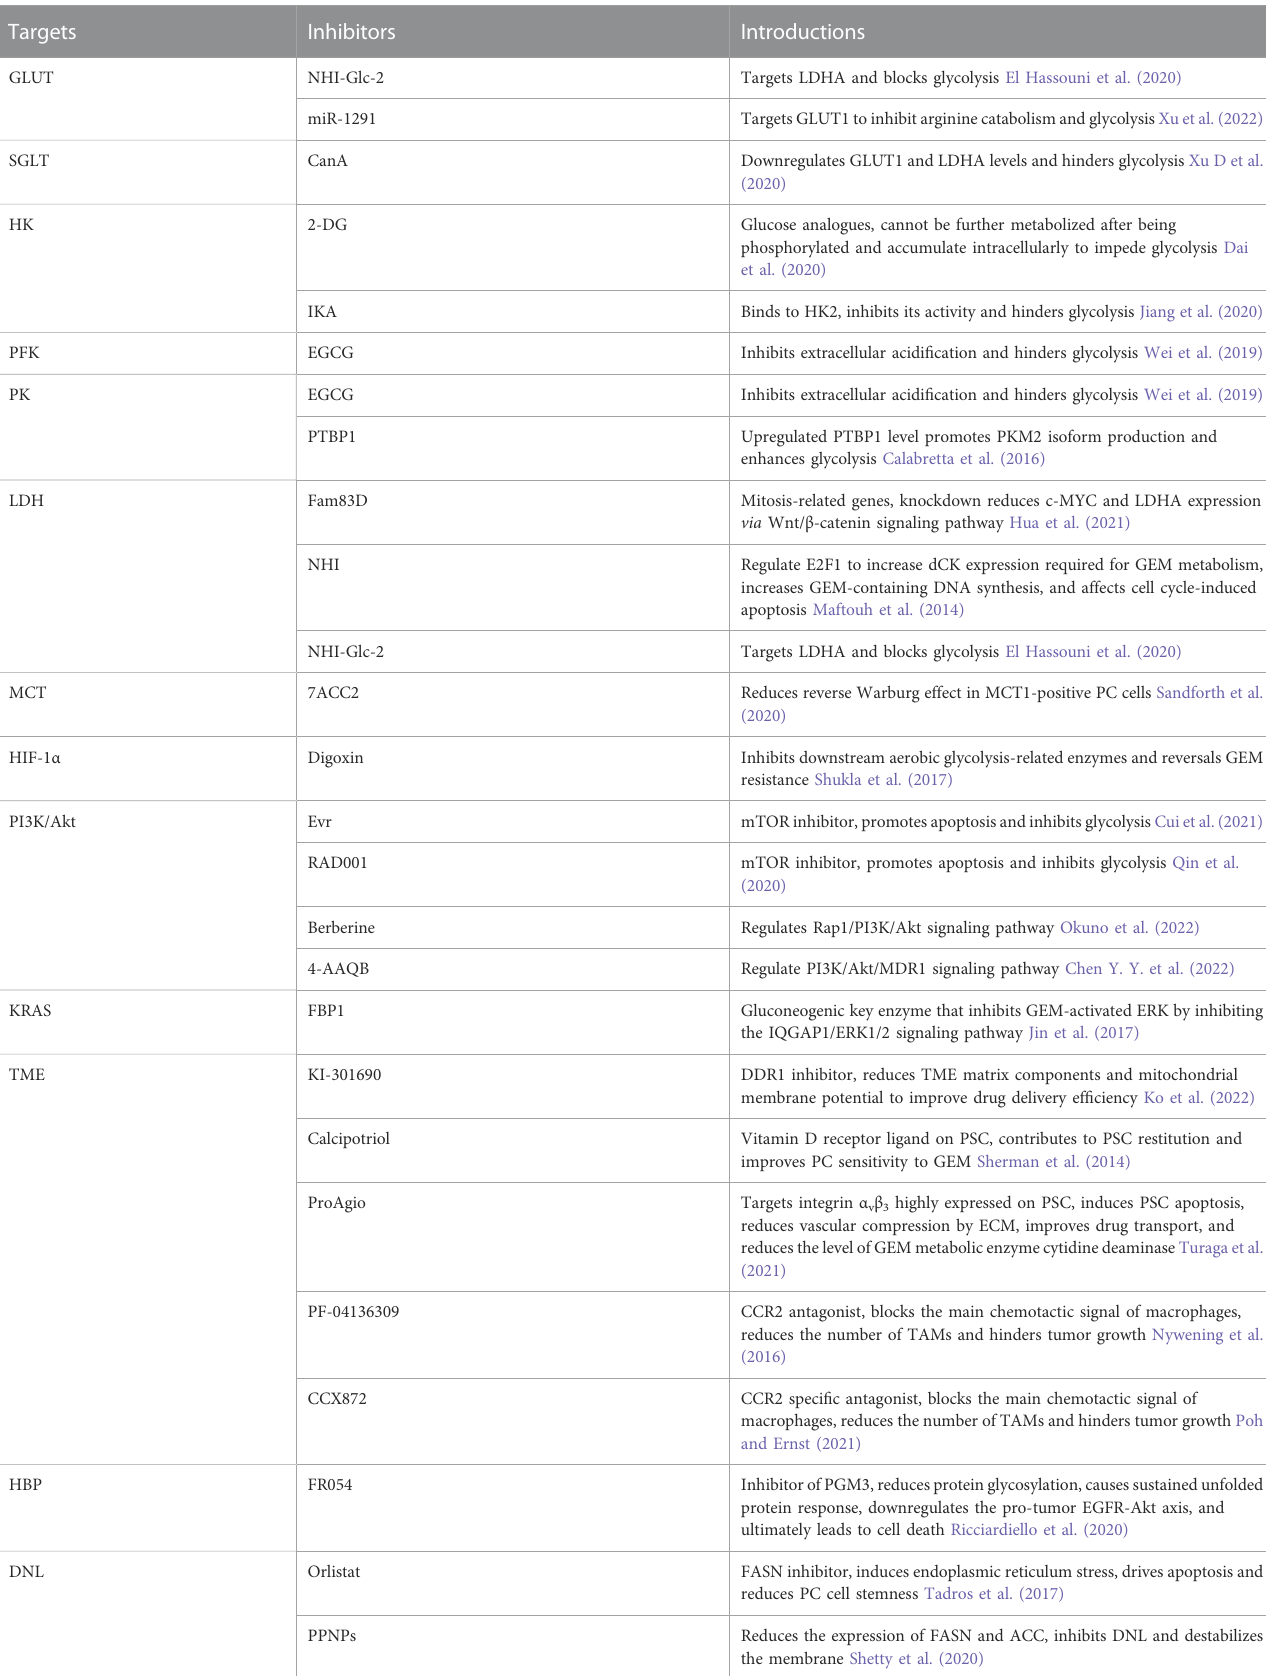
TABLE 1 Inhibitors used in combination with chemotherapy to overcome drug